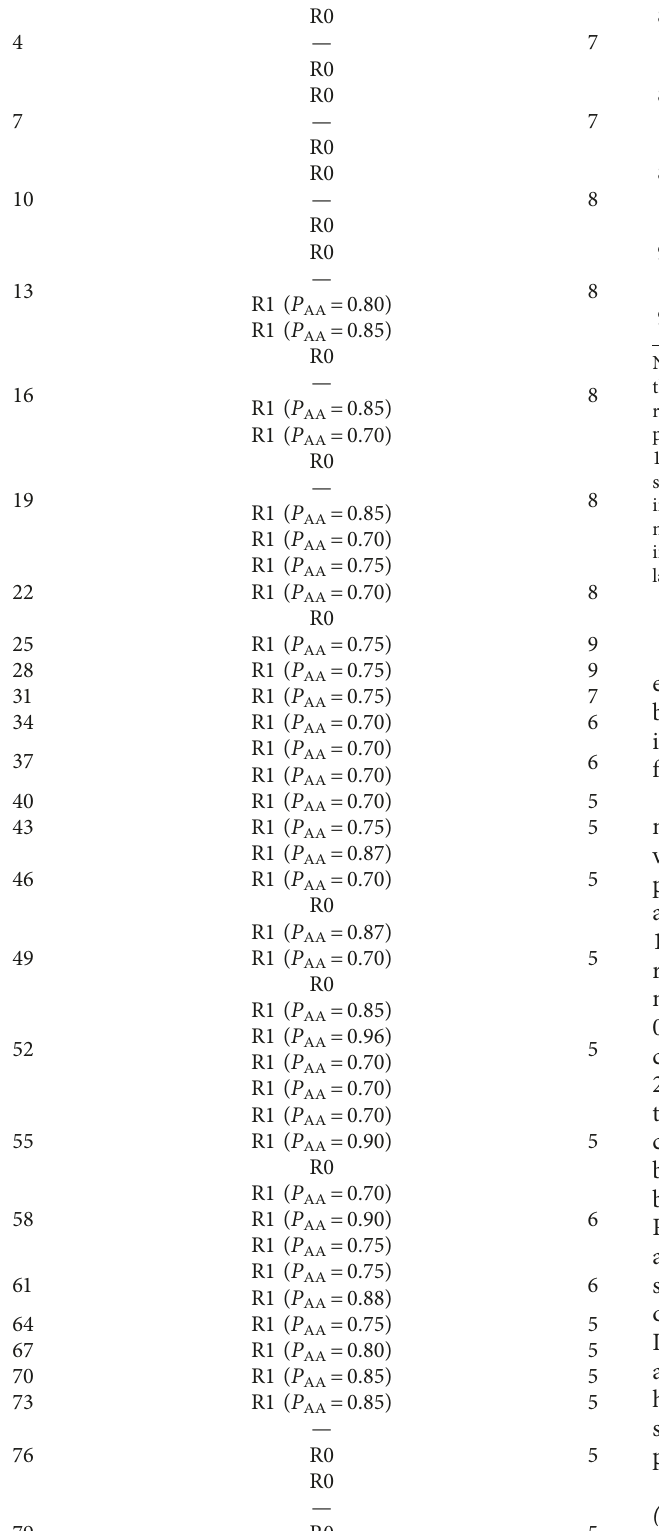
Table 1: SomestructuralparametersobtainedfromthequantitativeXRD analysis in the case of the unstressed sample along the sorption process. %RH